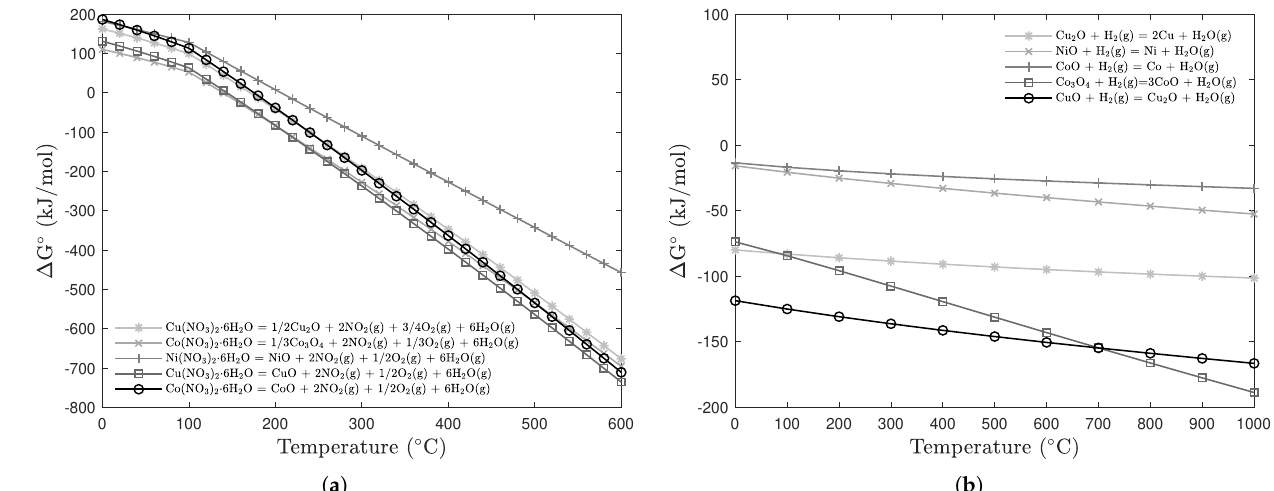
Figure 1. Thermodynamics diagram for ( a ) the thermal decomposition of nitrates; and ( b ) the hydrogen reduction of Cu, Ni and Co oxides.